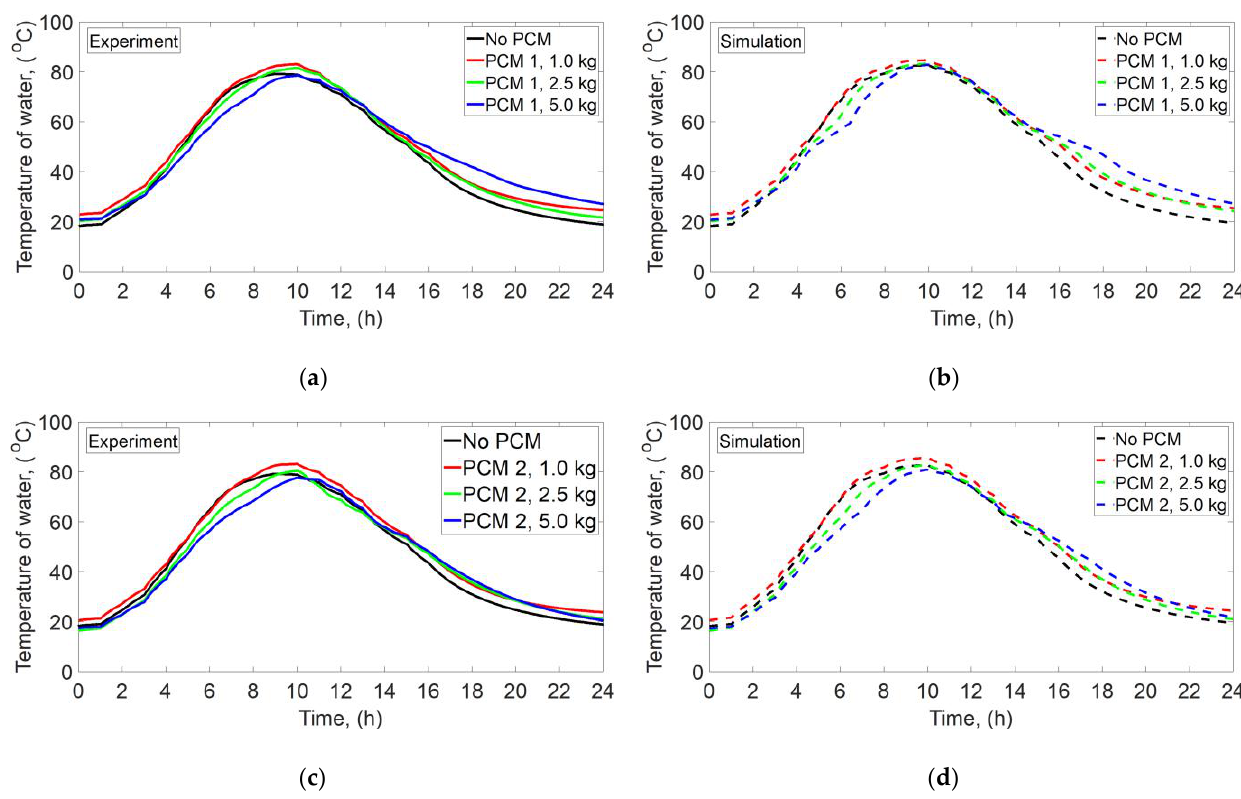
Figure 6. Temperature of ambient air (T air ) and temperature of water (T w ) for experiments (exp . ) and simulations (sim . ): ( a ) Experiment 1 (no PCM); ( b ) Experiment 3 (PCM 1, 1.0 kg); ( c ) Experiment 5 (PCM 1, 2.5 kg); ( d ) Experiment 7 (PCM 1, 5.0 kg); ( e ) Experiment 9 (PCM 2, 1.0 kg); ( f ) Experiment